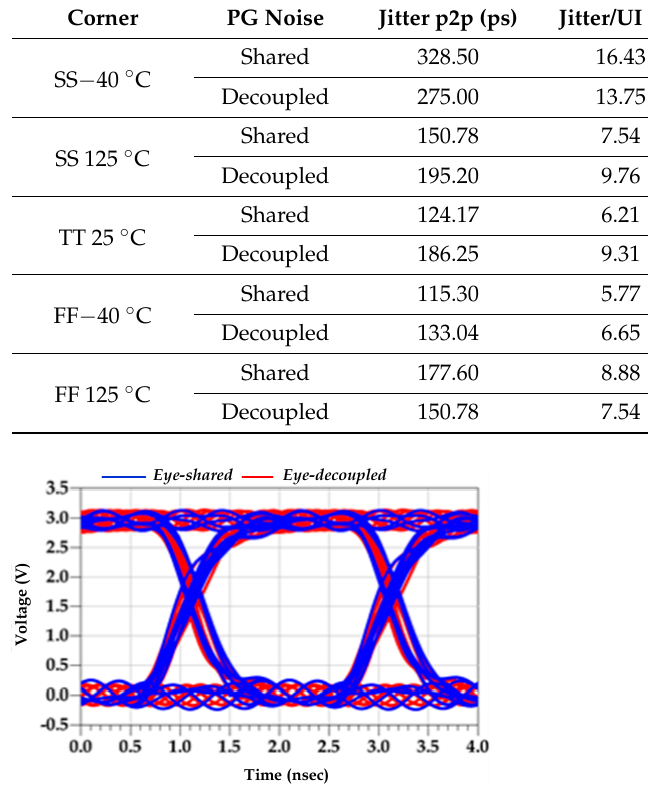
Figure 7. Eye diagram: shared vs. decoupled PGSIJ at SS − 40 °C. Figure 6. Eye diagram: pre-driver vs. last-stage PGSIJ at the SS − 40 °C corner. Table 5. Eye Diagram Metrics: Shared vs. Decoupled Cases